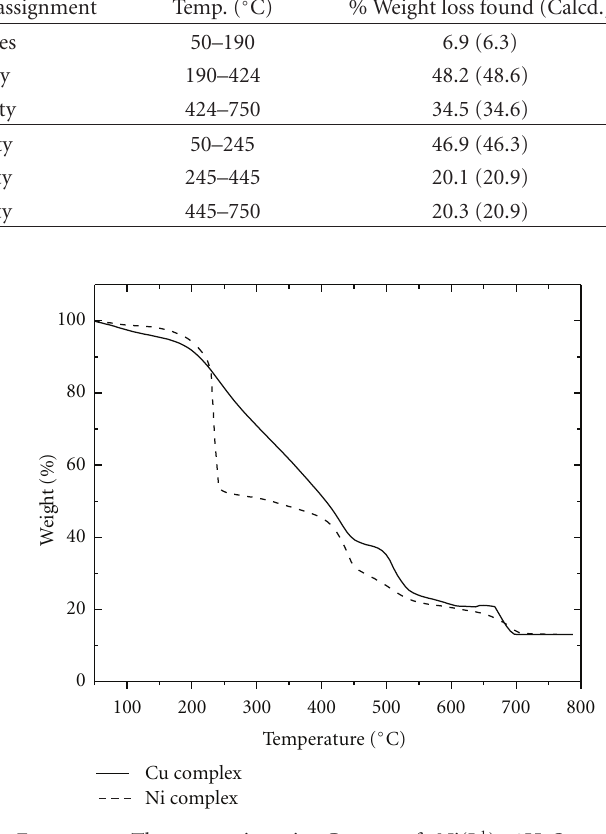
Figure 5: Thermogravimetric Curves of Ni(L 1 ) 2 · 2H 2 O and Cu(L 1 ) 2